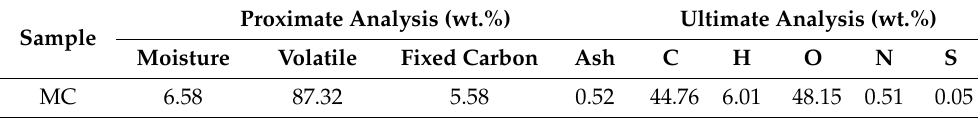
Table 1. Chemical characteristics of the MC.